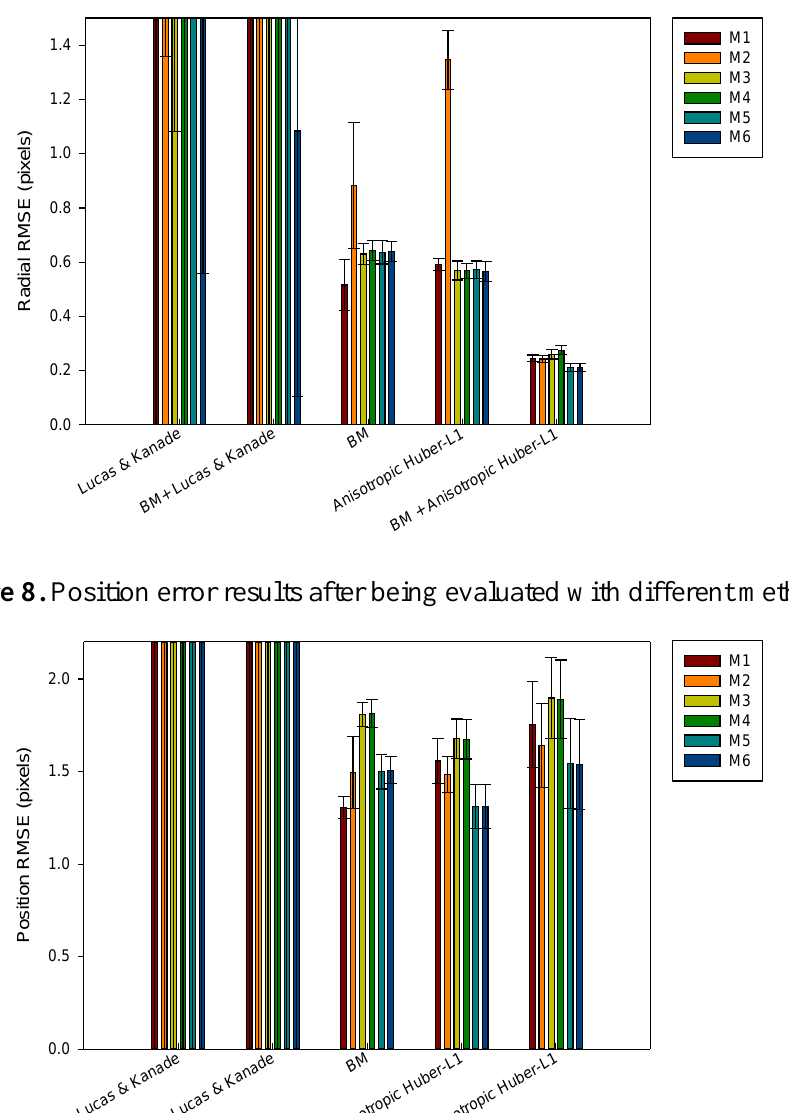
Figure 7. Radial error results after being evaluated with different methods.